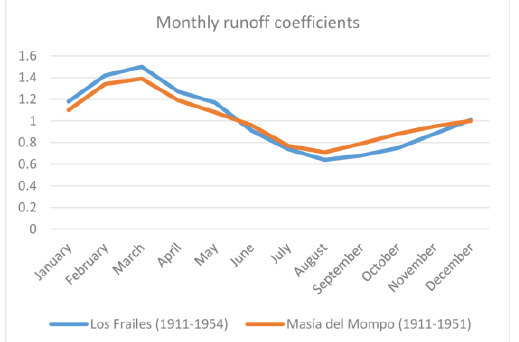
Figure 9. Monthly runoff coefficients of the Júcar at the Los Frailes (1911–1954) and Masía del Mompó (1911–1951) gauges before the construction of the Contreras and Alarcón reservoirs.